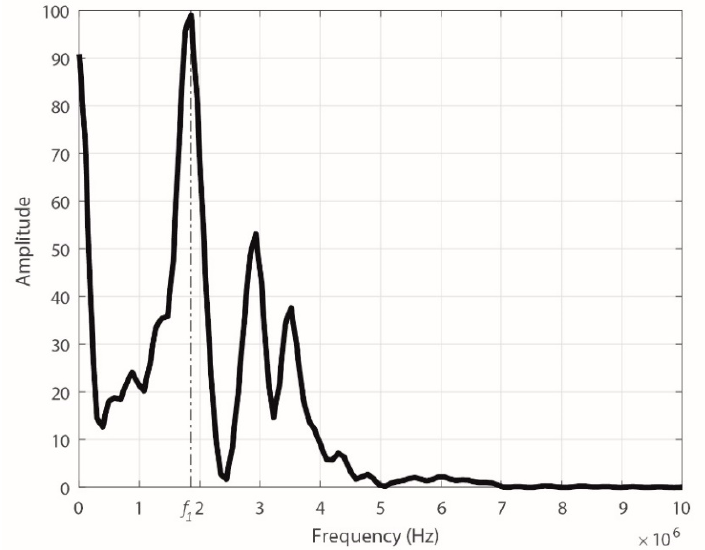
Figure 13. FFT of the signal captured by the ILS.